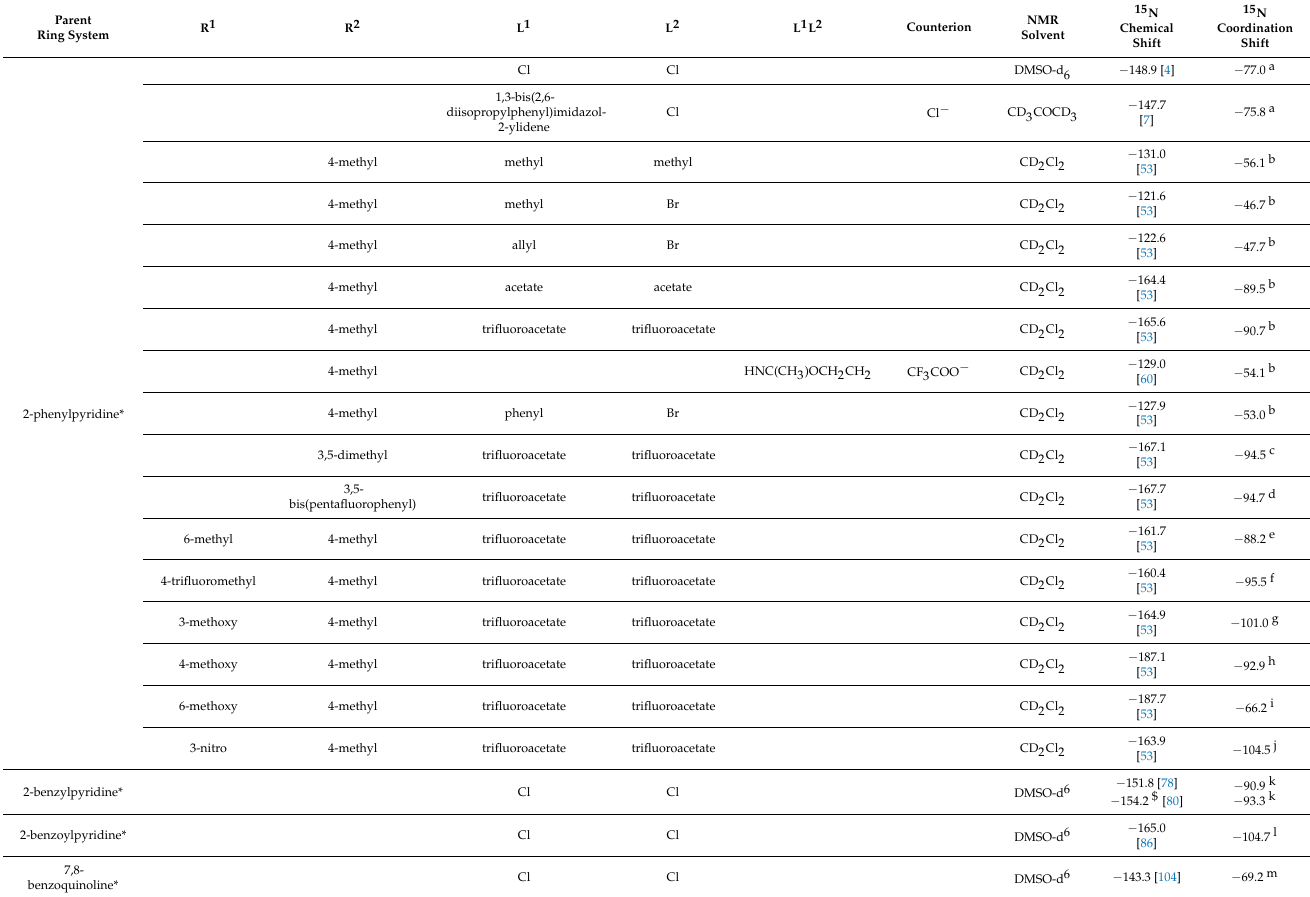
Table 9. 15 N chemical shifts (with respect to CH 3 NO 2 , in ppm— δ 15N ) and 15 N coordination shifts ( ∆ 15N coord ) for [Au(2PPY*)L 1 L 2 ], [Au(2PPY*)(L 1 L 2 )], [Au(2ArPY*)L 1 L 2 ], [Au(2ArPY*)(L 1 L 2 )], [Au(ArPY # *)L 1 L 2 ], [Au(ArPY # *)(L 1 L 2 )] compounds (L 1 , L 2 , L—monodentate ligands (including